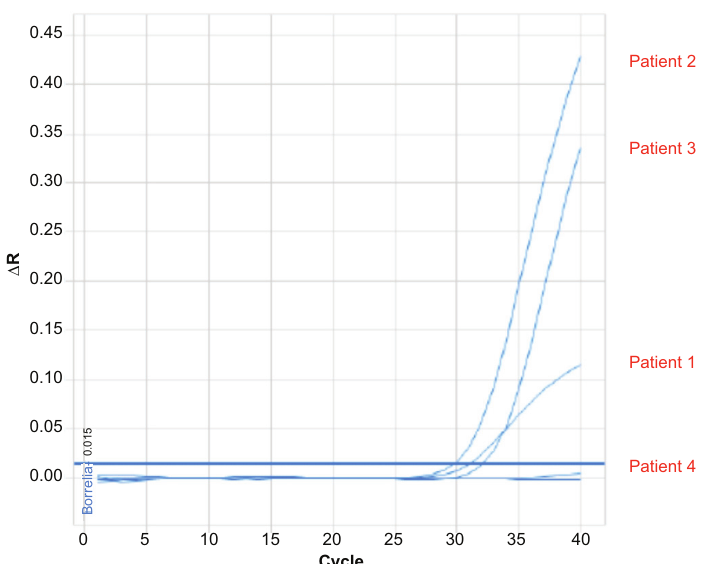
Figure 4. Results of polymerase chain reaction (PCR) amplification in tissue samples from patients 1–4. See text for PCR protocol. Samples from patients 2 and 3 were strongly positive, while the sample from patient 1 was weakly positive. The sample from patient 4 was